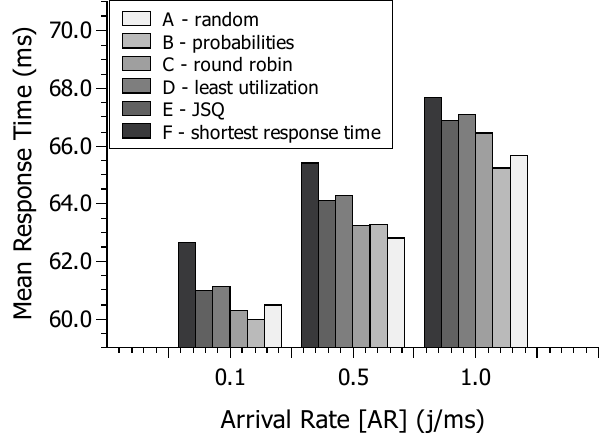
Figure 7. Results changing the arrival rate with routing strategies